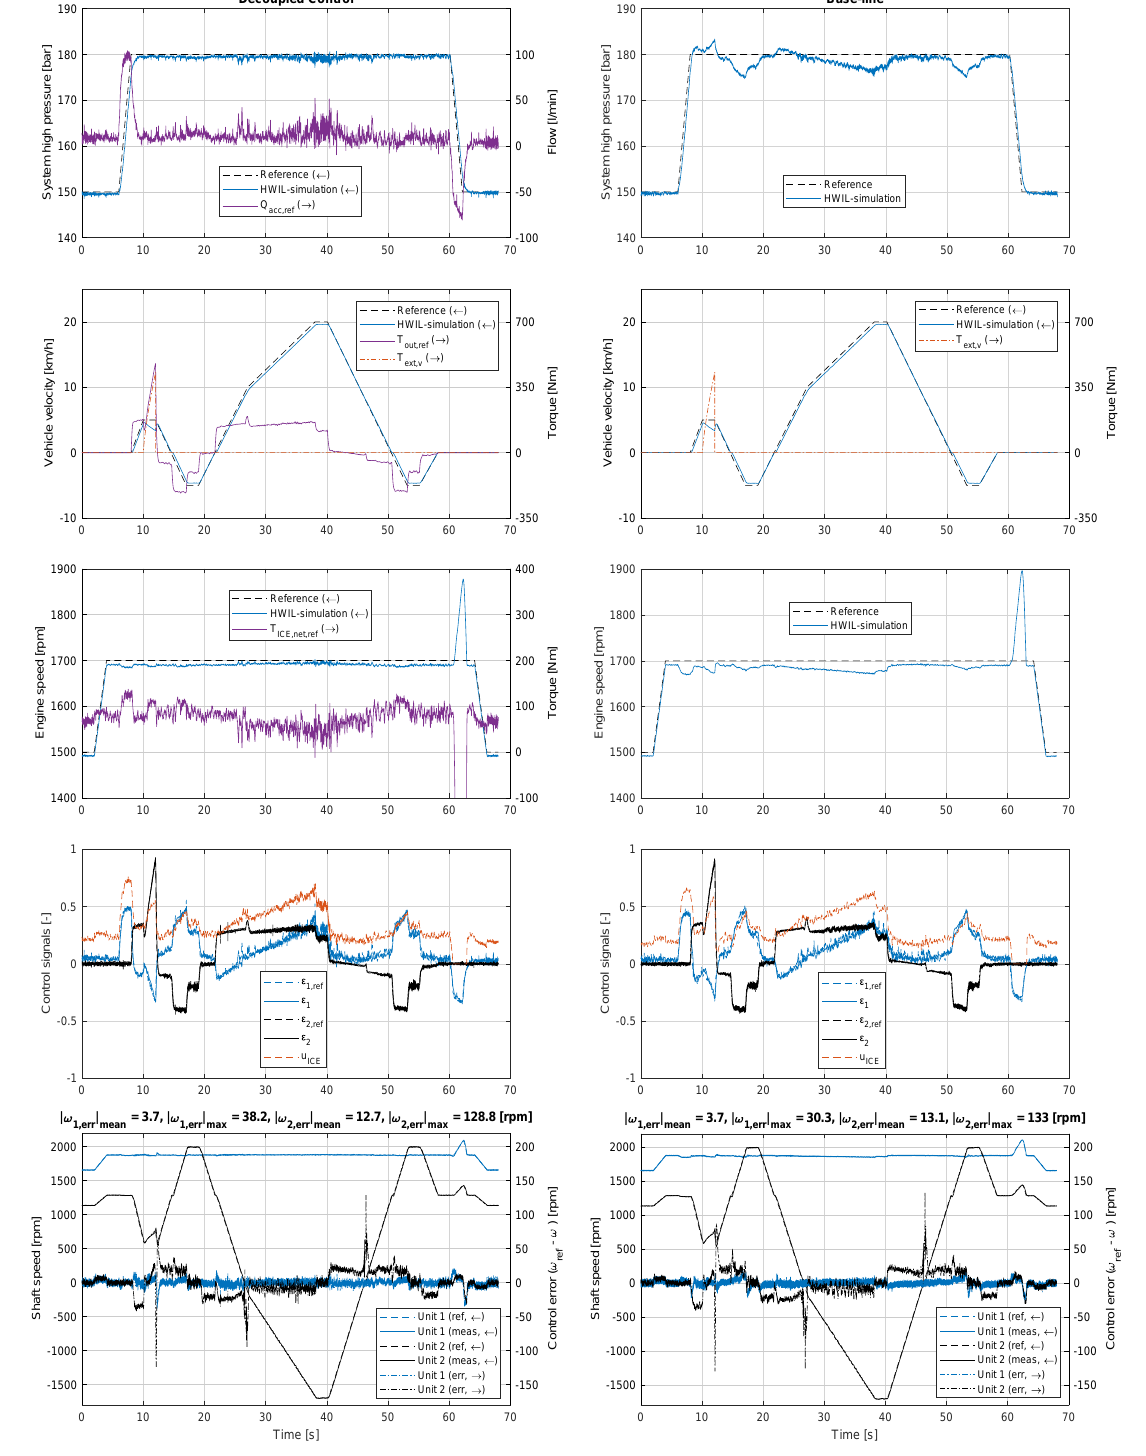
Figure 6. HWIL-simulation results of the load-and-carry cycle for decoupled (left column) and baseline (right column) control. Q ext and T ext , ICE are zero for this cycle and are therefore not included in the graphs. Note that the bottom row shows the performance of the HWIL simulation controller and not the transmission control strategy. The output shaft speed has been scaled to vehicle velocity via the (cid:16) (cid:17) ω out = v veh wheel radius and final gear ratio i 0 r w